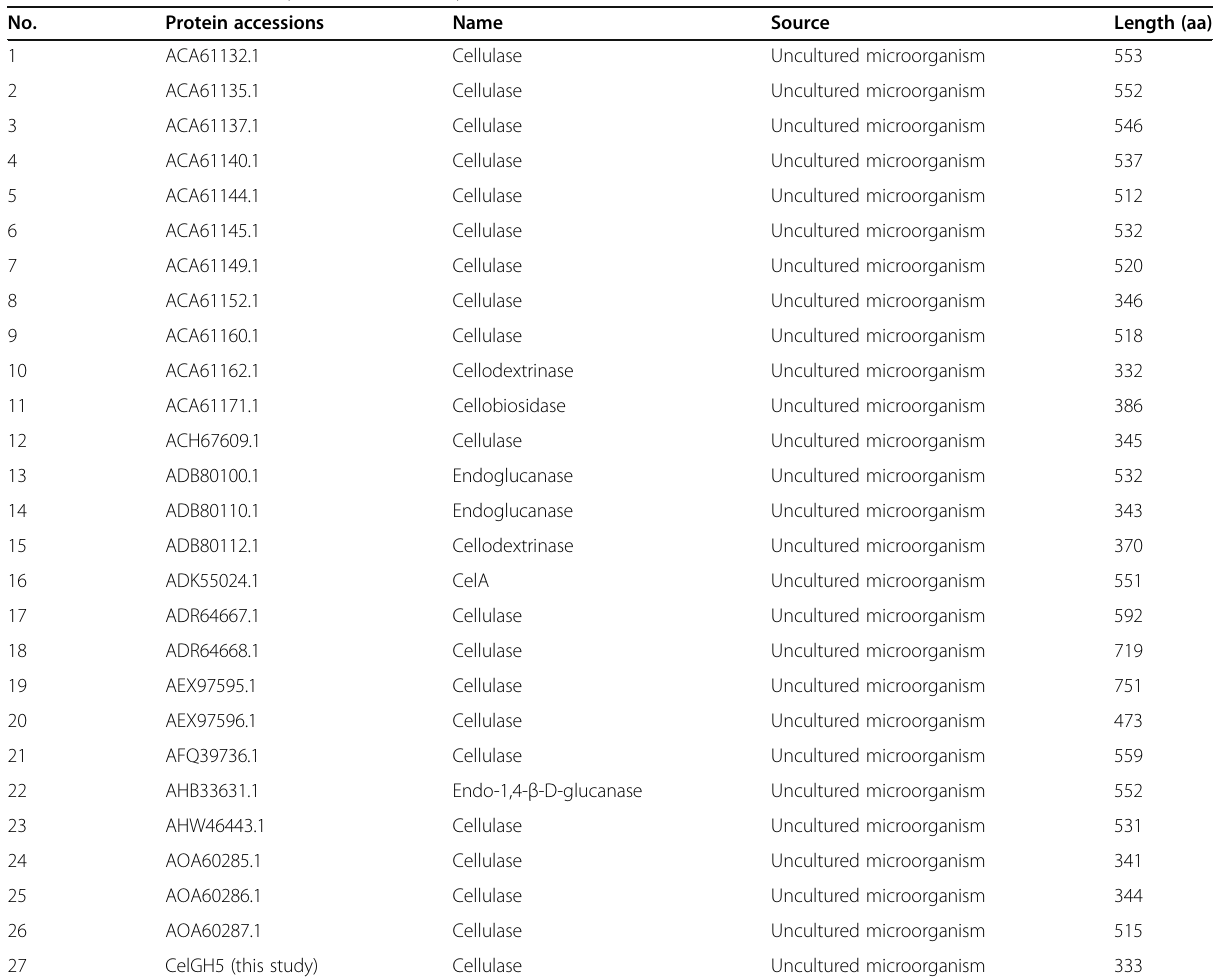
Table 1 Details of selected sequences with their protein accessions